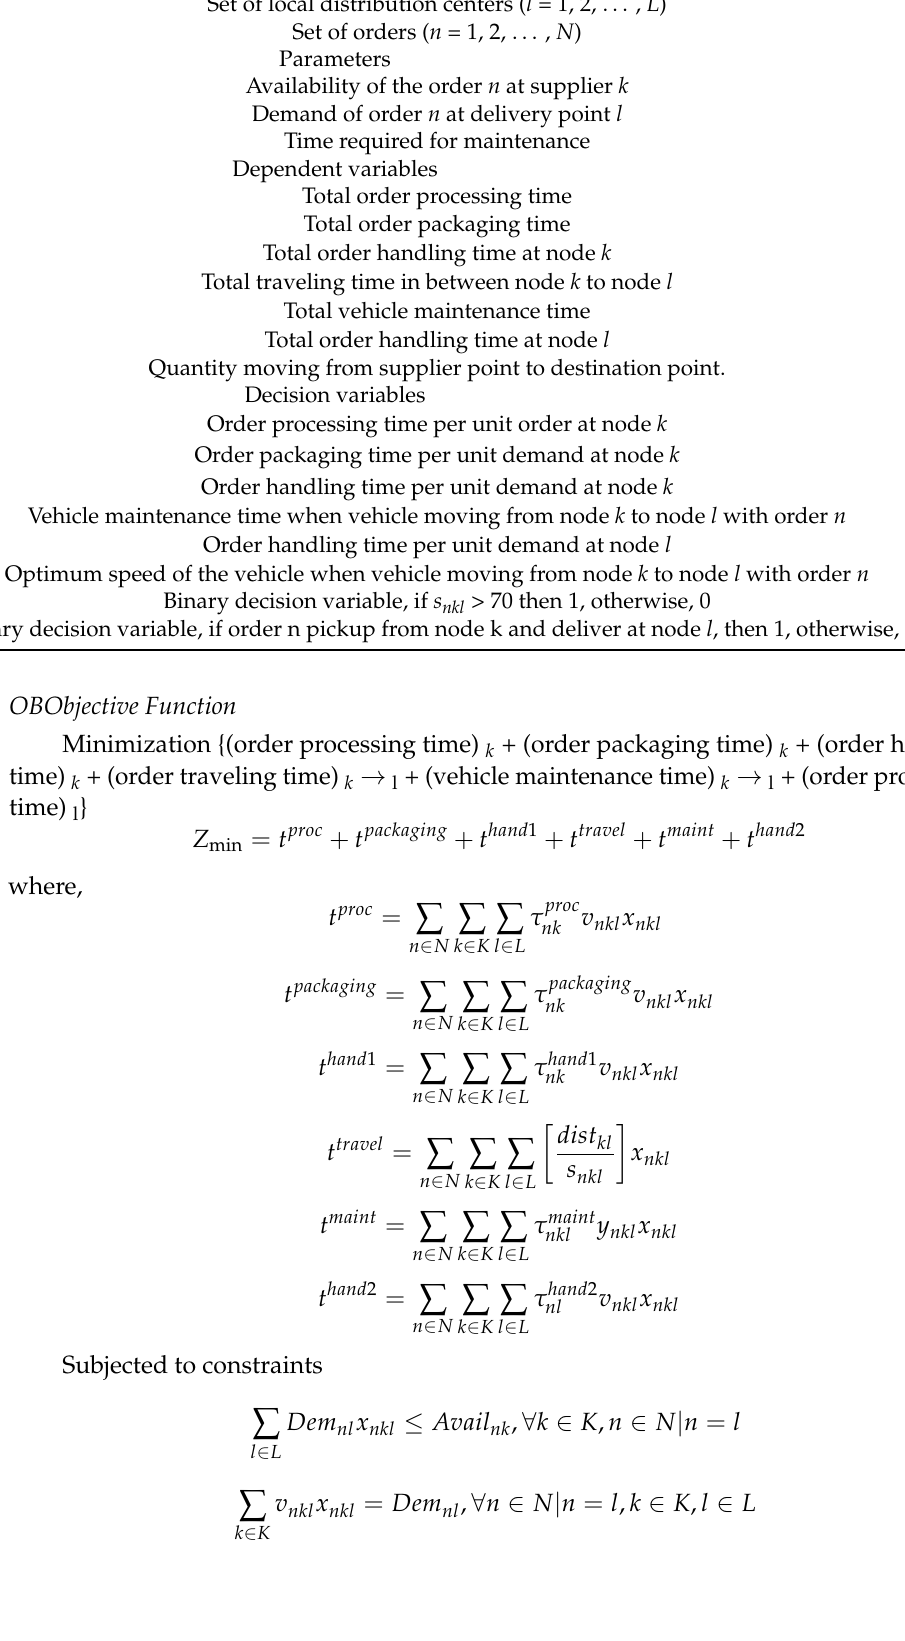
Table 1. Description of Terminology used in Mathematical Model. Sets and Indices S k Set of suppliers ( k = 1, 2, . . . , K ) Set of local distribution centers ( l = 1, 2, . . . , L ) Set of orders ( n = 1, 2, . . . , N